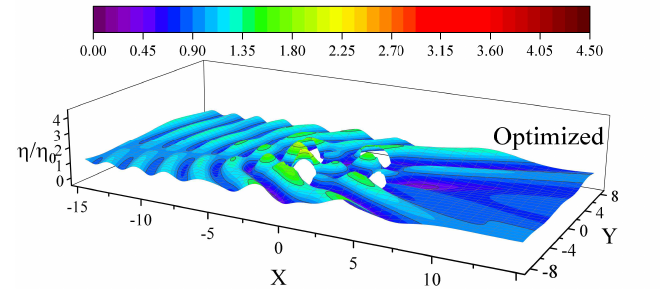
Figure 16. The free-surface elevation of optimized structure at k 0 a = 1.68.